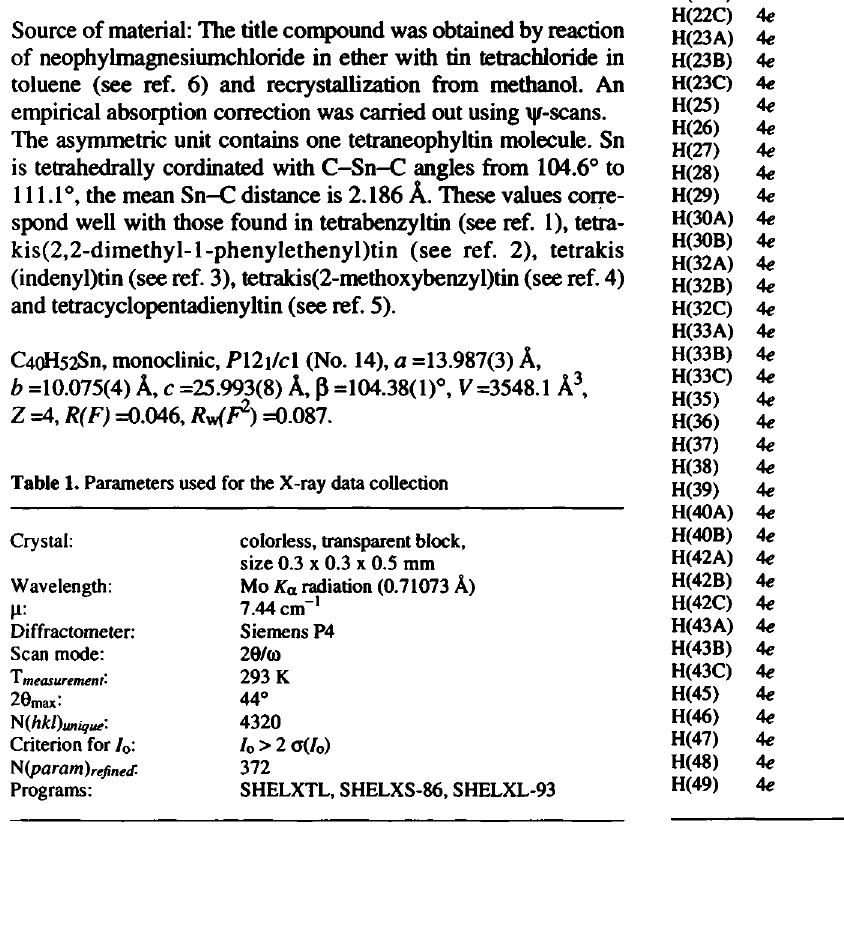
Table 1. Parameters used for the X-ray data collection